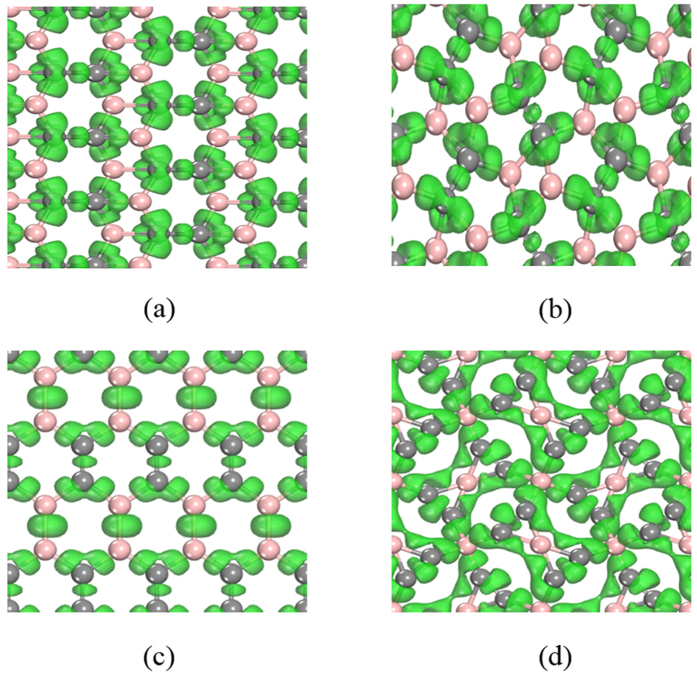
Electron localization function Isosurface.Isosurfaces of electron localization function (ELF) with the value of 0.75 for the structures (a) B2C2-a, (b) B2C2-b, (c) B2C2-c and (d) BC2.